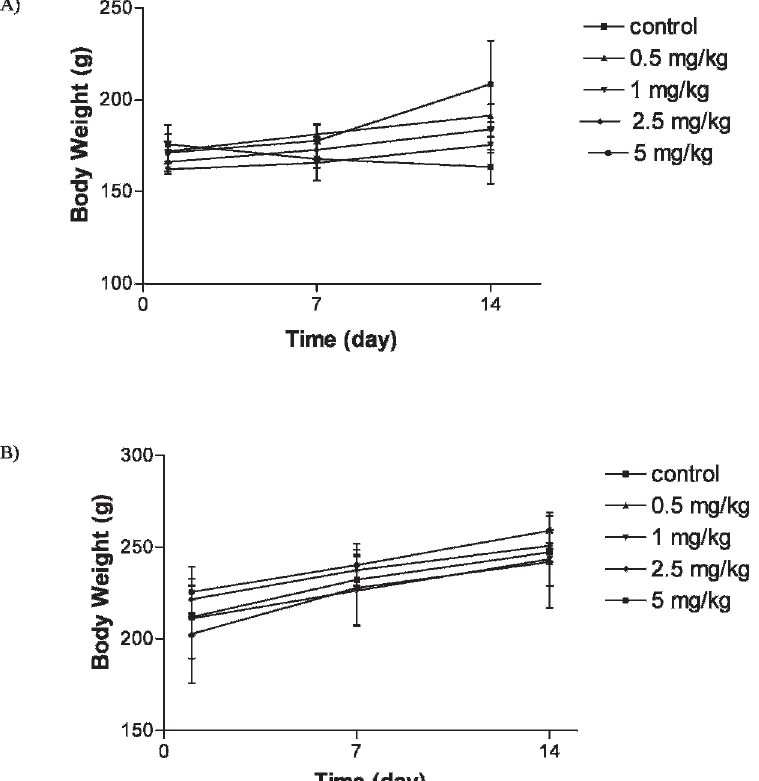
Figure 1 - Changes in male (A) and female (B) rats body weight with duration of acute treatment. Each point represents mean ¡ SEM,